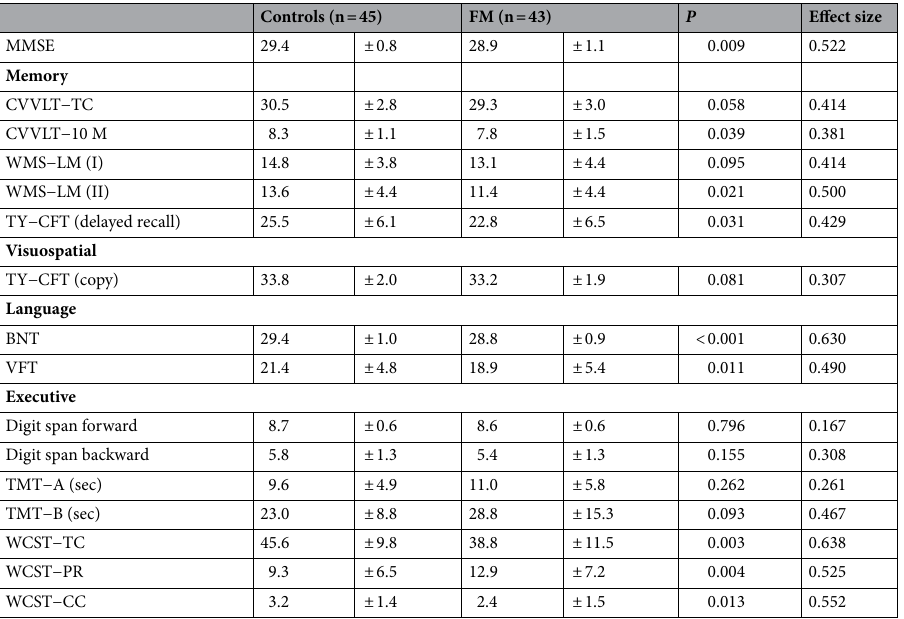
Table 3. Results of objective cognitive tests. All data are raw score (mean ± SD). Effect sizes are expressed as Cohen’s d. FM fibromyalgia, MMSE Mini–Mental State Examination, CVVLT–TC Chinese Version